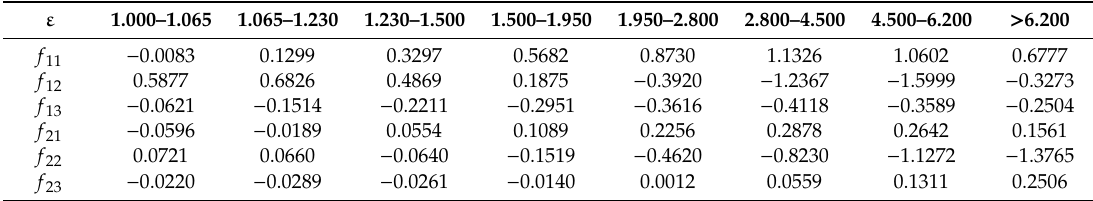
Table A1. Table for the selection of the coe ffi cients f in function of the coe ffi cient of transparency of the sky according to the Perez method (see step S15 of Figure